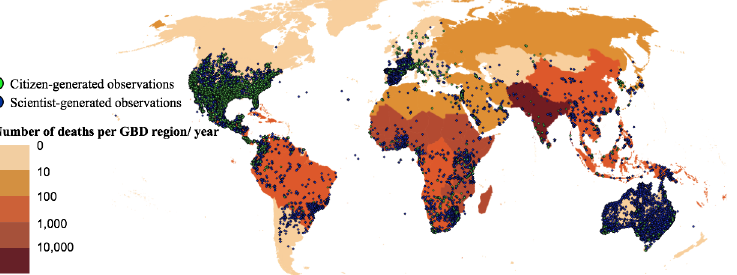
Fig 1. Geographical distribution of MIVS citizen-generated ( n = 9,113) and scientist-generated ( n = 70,697) observations on global map illustrating snakebite mortality for GBD regions of the world. The time frames for citizen-generated and scientist-generated observations are from 1967 to 2017 and 1700 to 2016 respectively. The color scale illustrates the mortality for these regions based on figures provided by Kasturiratne et al. (2008) [12]. Source: Made with Natural Earth. Free vector and raster map data available from www.naturalearthdata.com. The map (countries cultural theme version 3.1.0) is adapted and projected in the World Robinson coordinate reference system on QGIS 2.18.2. Abbreviations: GBD, global burden of disease; MIVS, medically important venomous